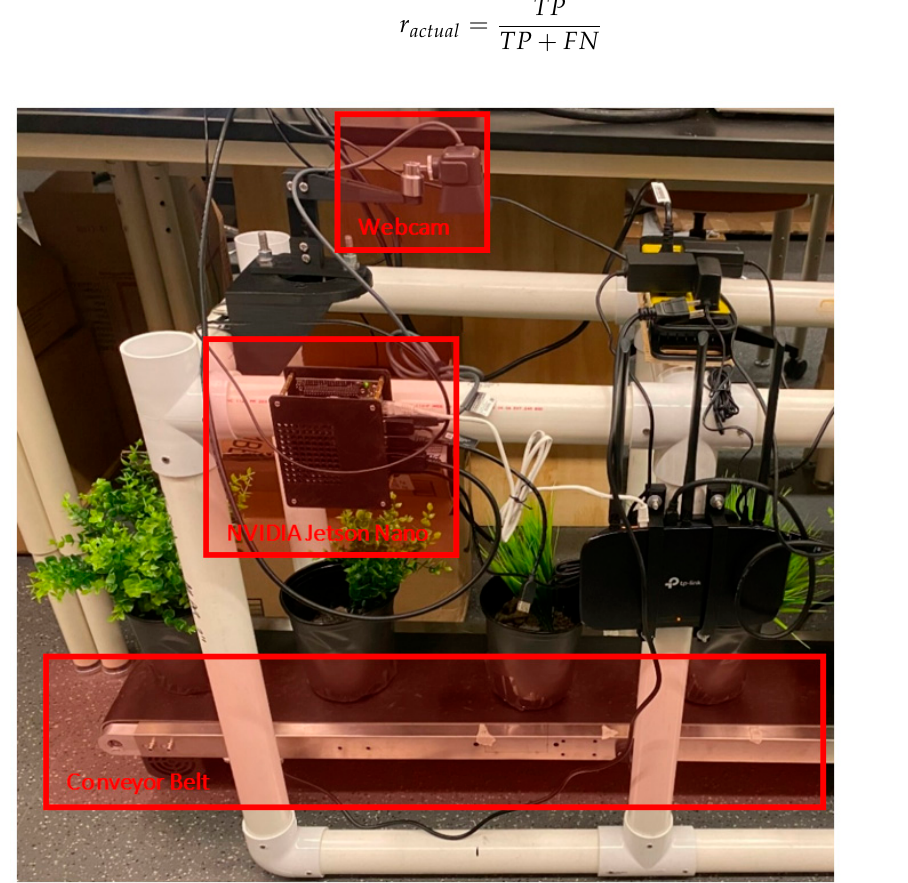
Figure 6. Laboratory setup composed of Jetson Nano 4 GB, Logitech StreamCam Plus, and variable speed conveyor belt with artificial potted plants.